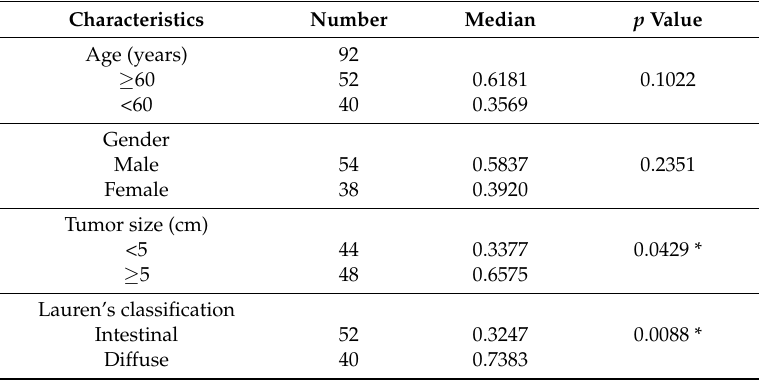
Table 1. Association between the clinicopathologic parameters and miR-103 expression in gastric cancer